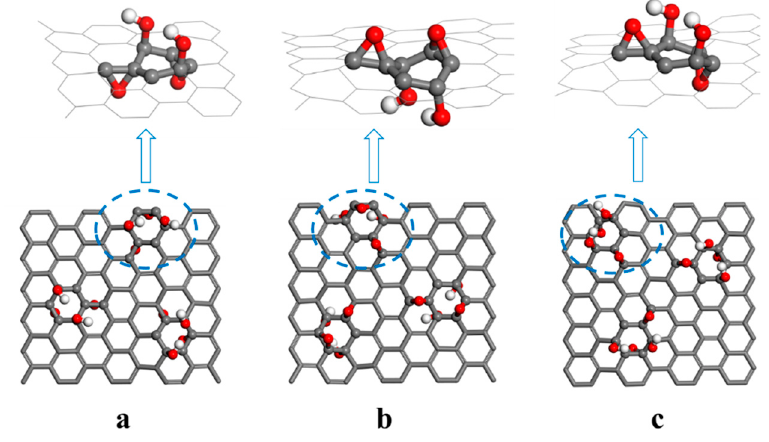
Figure 3. ( a – c ) Representation of three graphene oxide (GO) models.